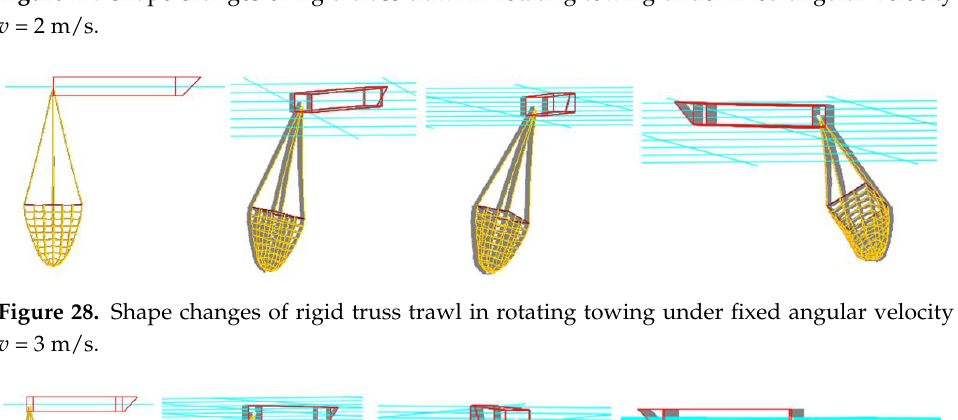
Figure 27. Shape changes of rigid truss trawl in rotating towing under fixed angular velocity at v =